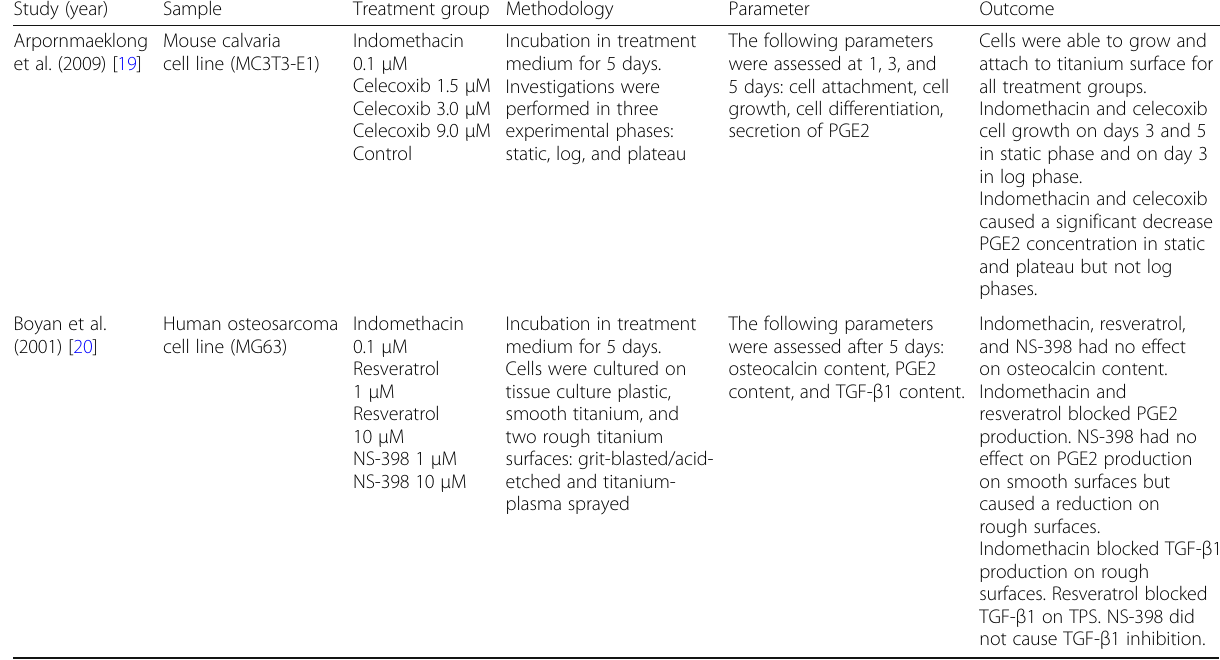
Table 6 In vitro studies that investigated the effect of NSAIDs on osteoblasts attached to titanium surfaces Study (year) Sample Treatment group Methodology